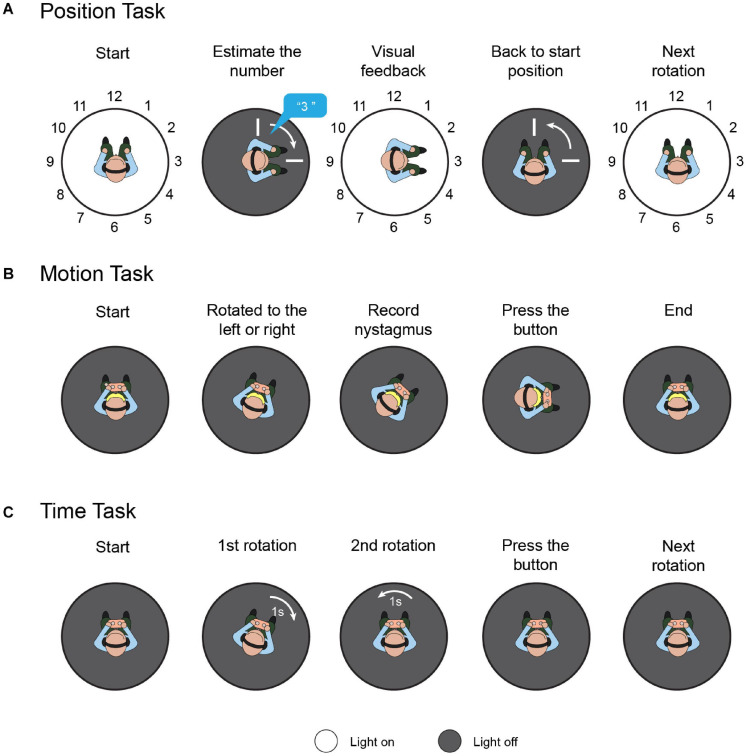
Task protocols. (A) Position task. Participants were instructed to sit on a rotational vestibular chair; the inner face of the chair enclosure was marked with 12 numbers. First, the participant faced number 12. Then, the participant was randomly rotated to the left or right. The participants were asked to estimate the number they were facing without providing them with any visual cues. The light was then switched on to reveal that number and the participants returned to the initial position. This process was repeated to involve all orientation directions, velocities, and angle amplitudes. (B) Motion task. Participants sat holding a control panel with two buttons. The chair rotated to the left or right randomly from rest with the acceleration increasing by 0.5 deg/s2 every 3 s, and rotation-induced vestibular nystagmus was recorded. When the participants felt they were rotating, they pressed the corresponding button. (C) Time task. Each time task comprised two rotations with equal duration and opposite direction, in random order. After the two rotations, the participant was instructed to press the button corresponding to the rotation with the longer duration.